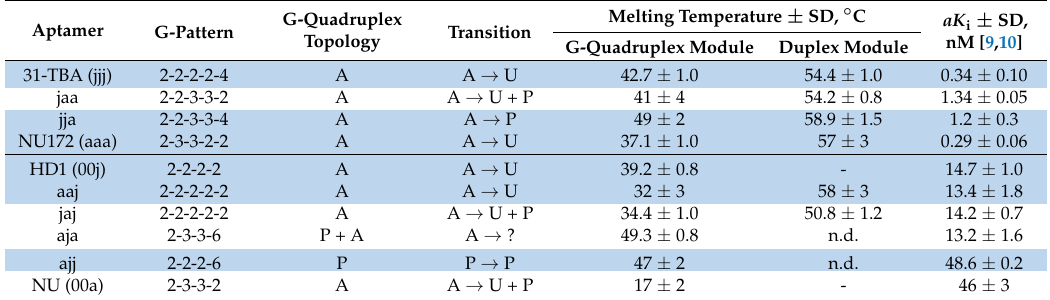
Table 2. Properties of the set of aptamers obtained from CD and UV melting